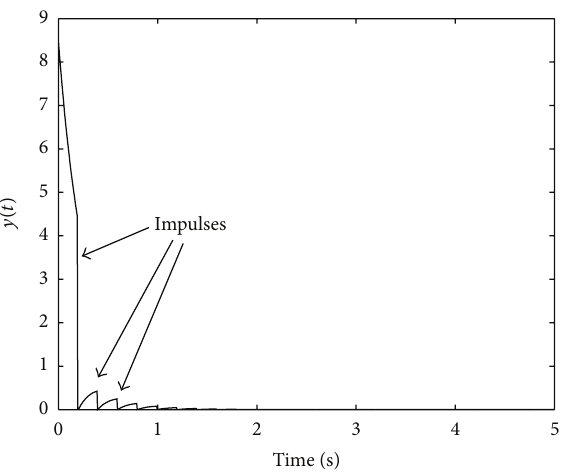
Figure 9: System output in the presence of impulses.